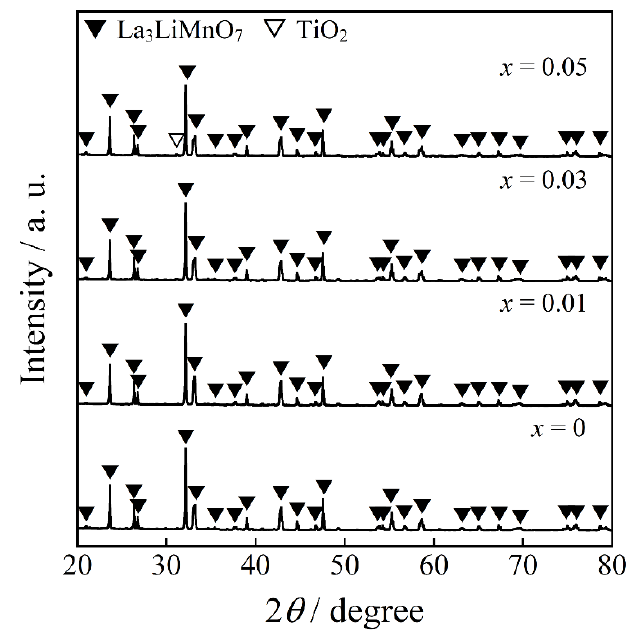
Figure 1. XRD patterns of the La 3 LiMn 1− x Ti x O 7 (0 ≤ x ≤ 0.05) samples.